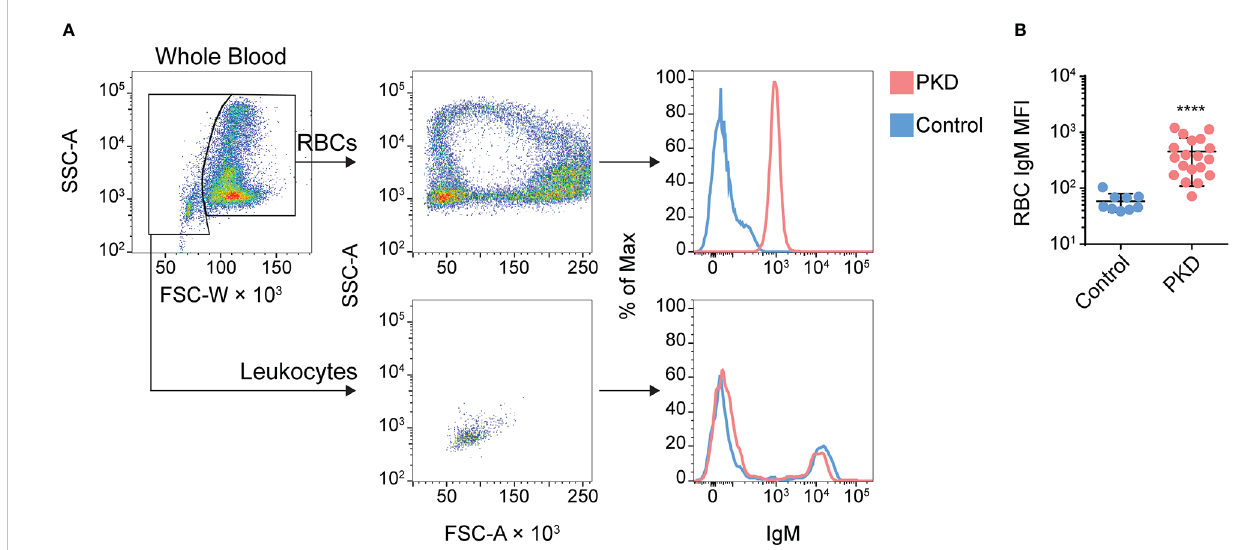
FIGURE 1 IgM + red blood cells (RBCs) are detectable and abundant in the circulation of rainbow trout with proliferative kidney disease (PKD). (A) Here, we give an example of the gating strategy we used for discrimination of RBCs from non-RBCs/leukocytes RBCs can be largely identi fi ed by their distinct side scatter area (SSC-A) versus forward scatter width (FSC-W) pro fi le (top left panel). Better resolution can be achieved via DiOC6 staining (Supplementary Figure 4). We present the result in the middle column: a ring pro fi le for RBCs (top) and an FSC- and SSC-low population characteristic of lymphocytes (bottom). In the rightmost panels, we overlayed histograms of RBCs (top) or lymphocytes (bottom) from infected (red) or control fi sh (blue) after staining with mAb 1.14. The entire population of RBCs shifts clearly away from the population of control RBCs whereas leukocytes from the same two representative fi sh show no such difference. (B) Summary of the surface IgM phenotype for the entire cohort of control and PKD fi sh, with each point representing the gated RBCs from one individual and this population ’ s level of surface IgM. The mean +/- SD of the MFI of mAb 1.14 staining was plotted. The difference between the “ Control ” and “ PKD ” group was signi fi cant by the Mann-Whitney U test, ****P < 0.0001; n = 9 for control speci fi c pathogen-free fi sh and n = 19 for the PKD